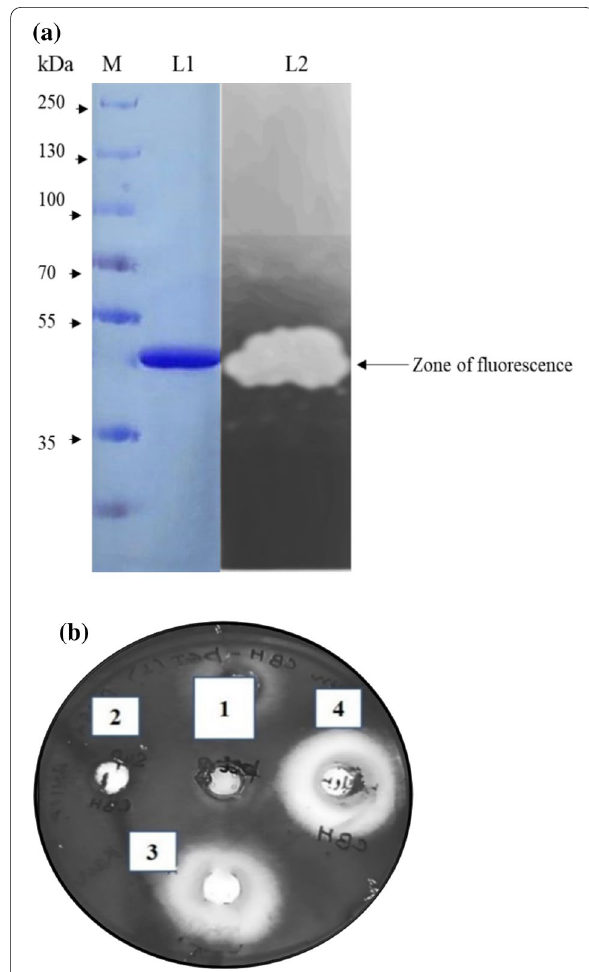
Fig. 4 a Purification and zymogram of rMtCel6A. M: protein marker, L1: purified rMtCel6A, L3: zymogram showing fluorescence [Protein ladder (PageRuler Plus prestained) was procured from Thermo Scientific] b Qualitative cellobiohydrolase assay of various fractions of rMtCel6A using 4-MUC as substrate, where well 1: negative control (pH 10 buffer only), well 2: supernatant fraction obtained after lysis of